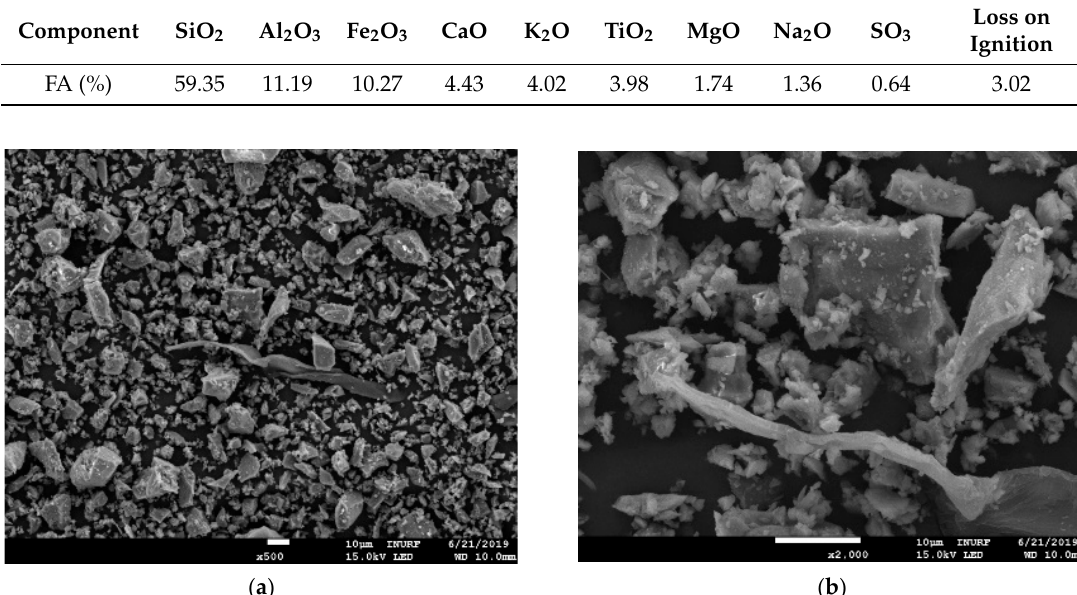
Table 3. Components of waste paper sludge ash (WPSA).